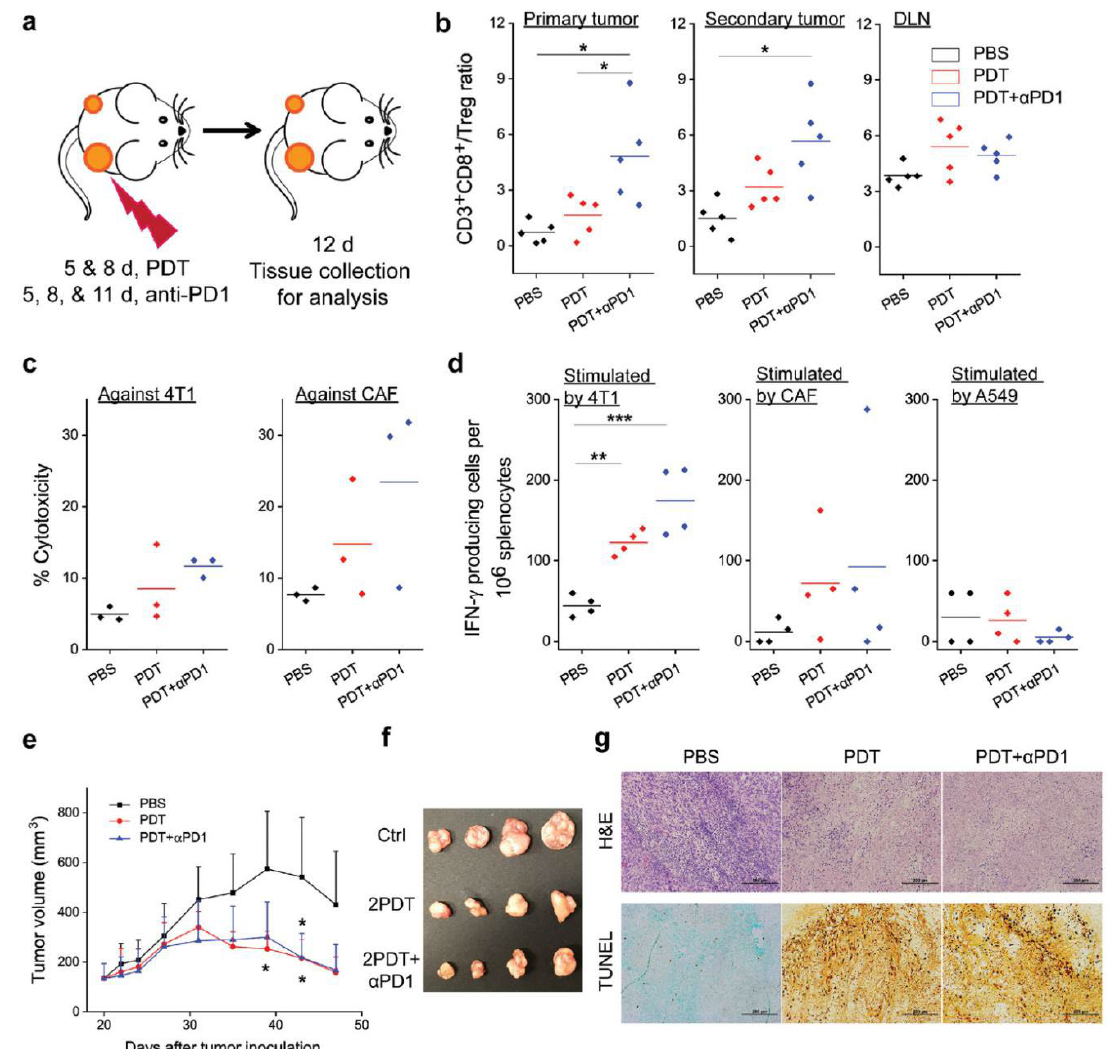
Figure 3. αFAP -Z@FRT induces anticancer and anti-CAF immunity [52]. ( a ) Schematic showing the treatment plan. ( b ) The ratios of CD3+CD8+ to Treg (CD3+CD4+FOXP3+) in primary tumor, secondary tumor, and tumor-draining lymph nodes (DLNs) were analyzed by flow cytometry. ( c ) Cell-specific cytotoxicity was assessed by propidium iodide (PI) staining followed by flow cytometry analysis. ( d ) IFN- γ -producing cells were quantified by enzyme-linked immune-absorbent spot analysis. ( e ) Growth curves of A549 tumors after adoptive cell transfer. ( f ) Photograph of A549 tumors taken on day 47 post A549 inoculation. ( g ) H&E and TUNEL staining, performed with A549 tumors taken on day 47. * p < 0.05; ** p < 0.01; *** p < 0.001.